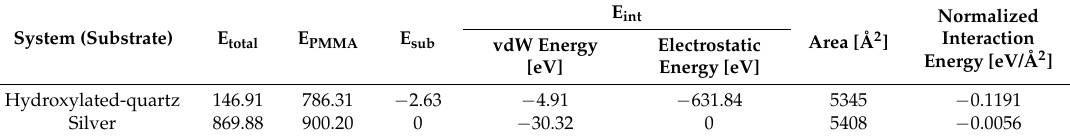
Figure 5. Snapshots of the simulated PMMA molecules adsorbed on ( a ) the hydroxylated-quartz surface and ( b ) the silver surface in x-z plane profile. Table 2. Simulative energy between PMMA and substrates of hydroxylated-quartz and silver.